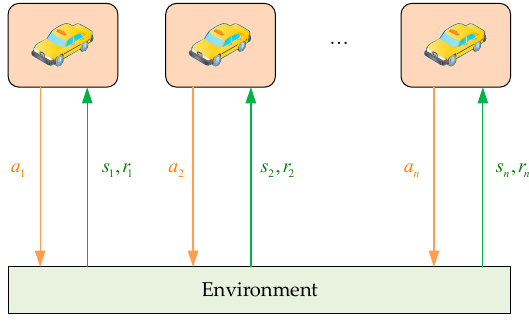
Figure 2. MARL framework.